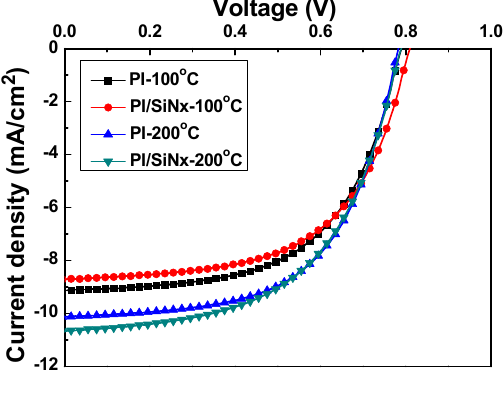
Figure 9. Current-voltage characteristics of the p-i-n α -Si:H thin-film solar cells under